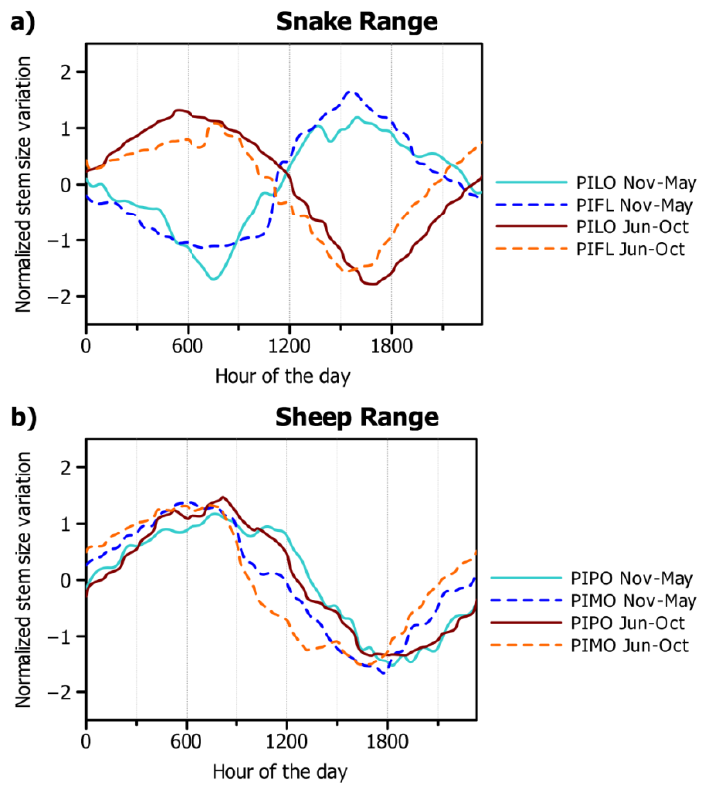
Figure 4. Daily circadian cycles calculated over three consecutive years (from January 2013 to December 2015) and averaged by species for the winter/spring (November – May) and for the summer/early autumn (June – October) at ( a ) the Snake Range, and ( b ) the Sheep Range. Species codes are the same as in the Figure 2 caption.